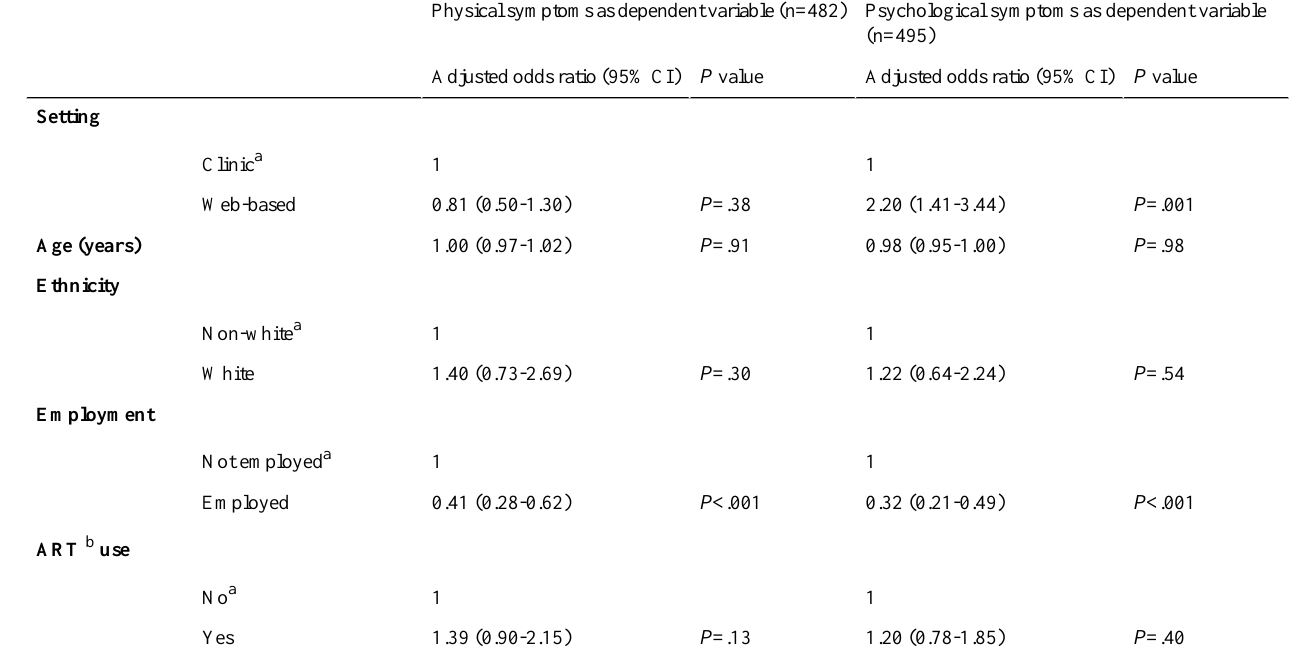
Table 2. Multivariable logistic analysis with (1) physical, and (2) psychological symptoms as independent variable, predicting upper tertile (ie, worst) symptom burden